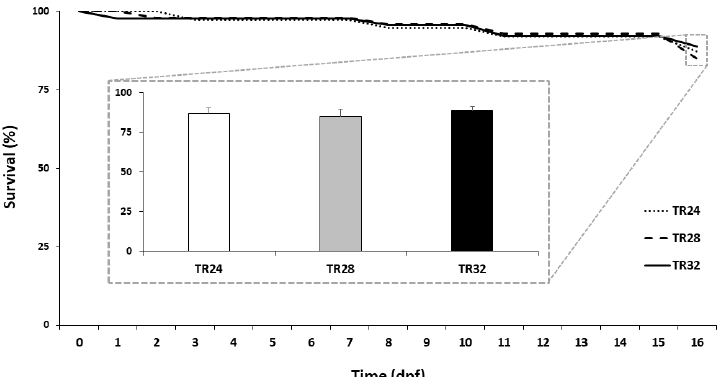
Figure 3. Mean survival of Atractosteus tropicus larvae along and at the end of the experimental trial (16 dpf) when embryos were incubated at different thermal regimens. The values of survival represented in the histogram bars are the mean ± standard deviation at 16 dpf.